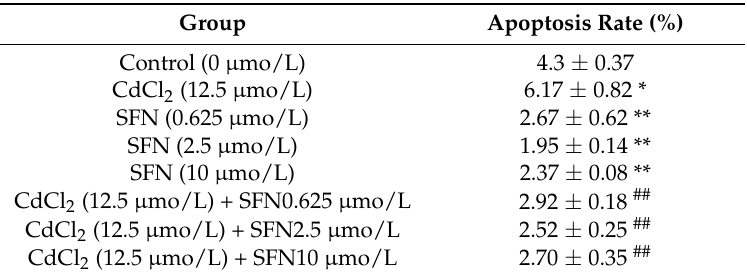
Table 2. Effect of SFN on the apoptosis of Cd ‐ induced TM4 cells.